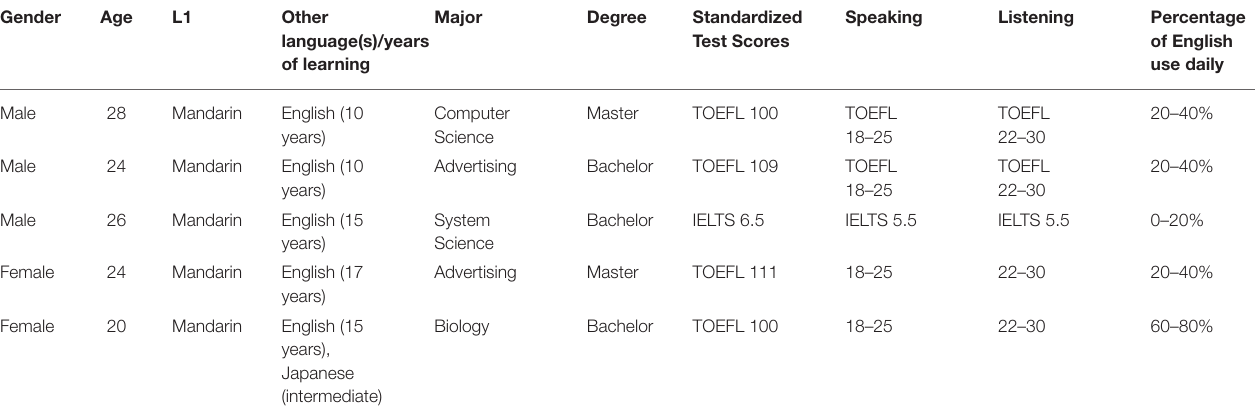
TABLE 3 | Mandarin-English L2 speakers’ biographical information * .